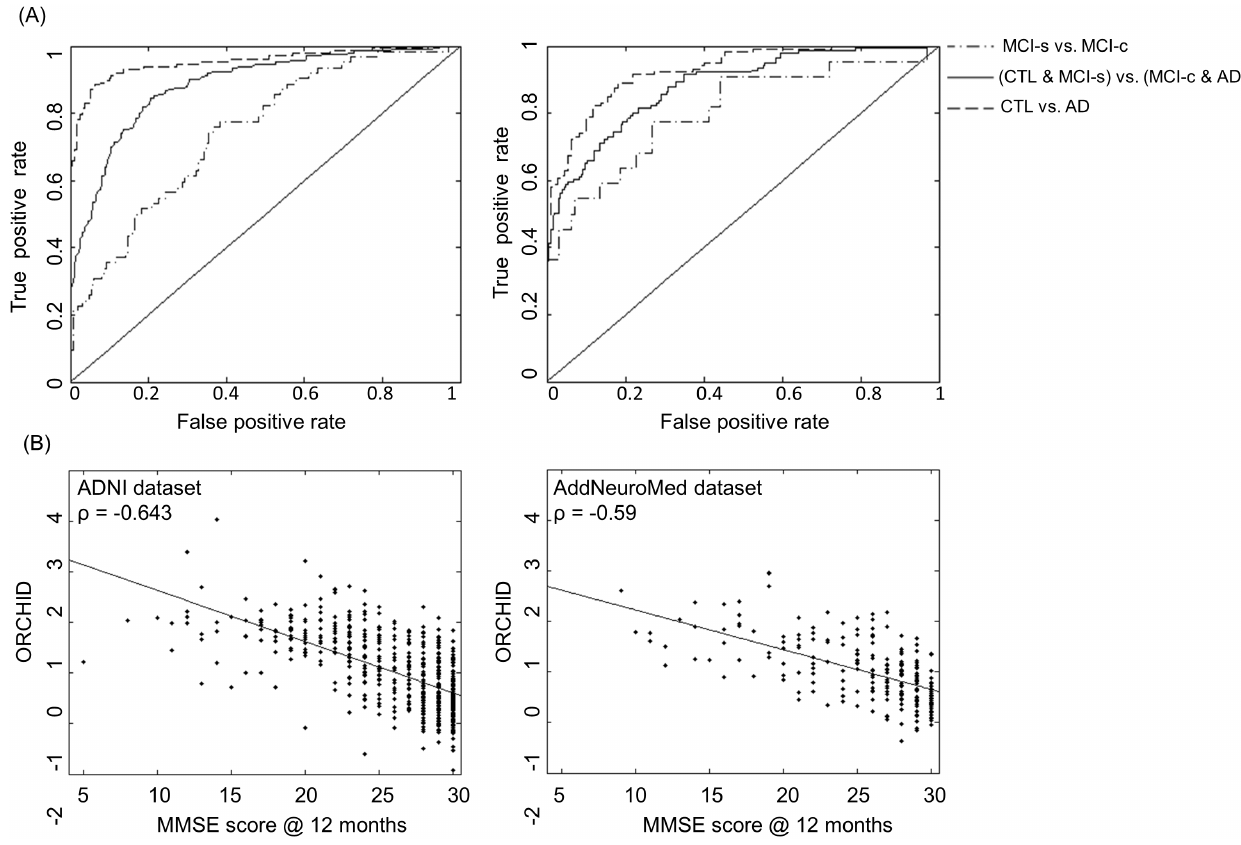
Figure 2. Performance curves and correlation plots for ordinal regression. (A): ROC curves for ordinal regression applied to the ADNI data set using 10-fold cross-validation (first panel) and using the AddNeuroMed data set as an independent test set. In both cases the ROC curves are shown from three contrasts. (B): Correlation plots of the MMSE score assessed at the 12 month follow-up against the Ordinal Regression Characteristic Index of Dementia (ORCHID) score for both the ADNI dataset and the AddNeuroMed dataset.